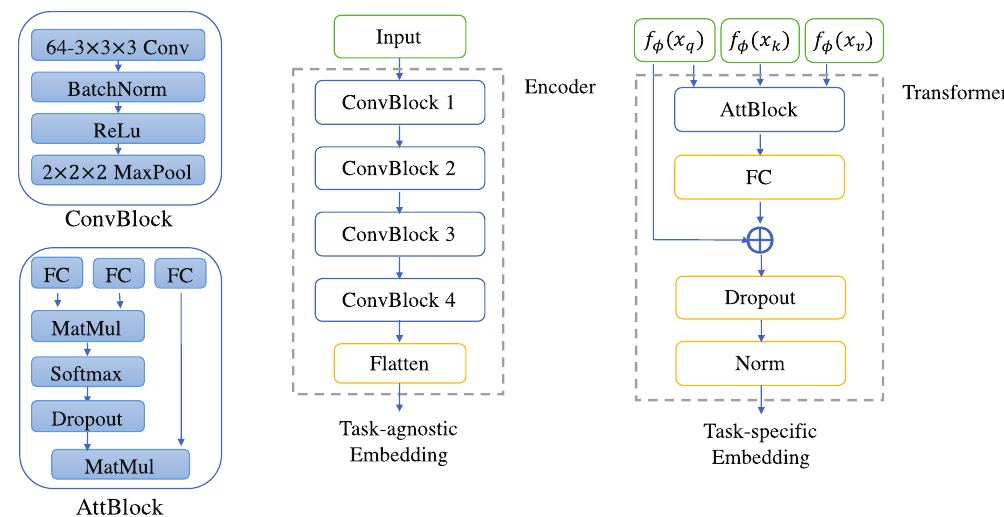
Fig 3. Architectures of our ProtoNet-CE network. Details of the 3D encoder and the transformer.